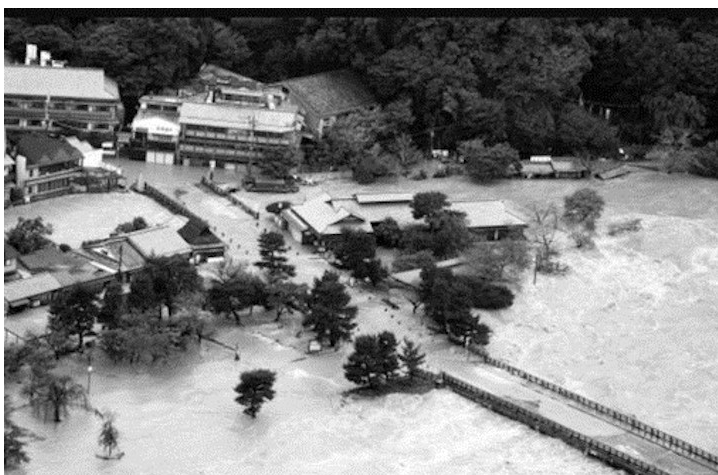
Figure 6. Togetsukyo bridge, Arashiyama, 2013 flood Source: Asahi Journal News Portal,